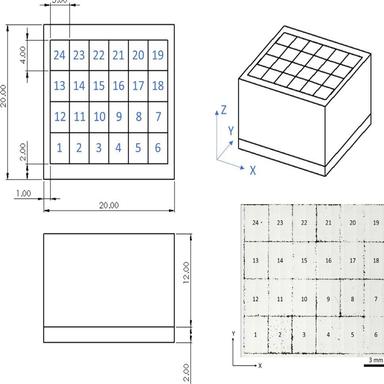
Drawing and dimensions of combinatorial sample. Units are in mm. Cross-sectional optical micrograph of the printed part for the Z plane. The laser process parameters for each column number are given in Table 2. Positive Z is the build direction and negative X is the recoating direction. The surrounding shell and base are printed with default settings. The print order starts with the shell and fills in the columns from 1 to 24.